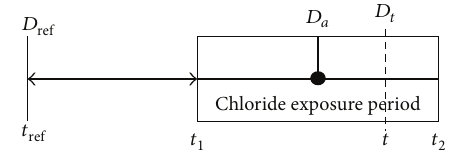
Figure 5: The scheme of exposure